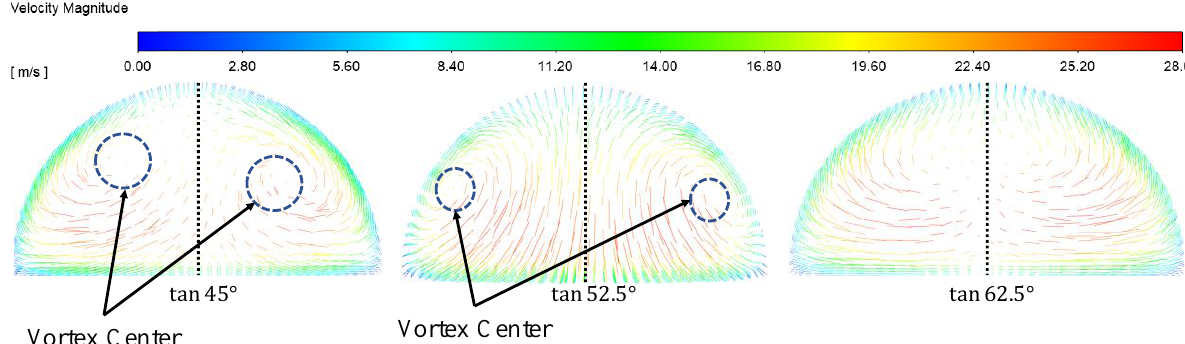
Figure 29. The vortex changes under the influence of A within the same cross-section (cross-section ID_8 in Figure 17).